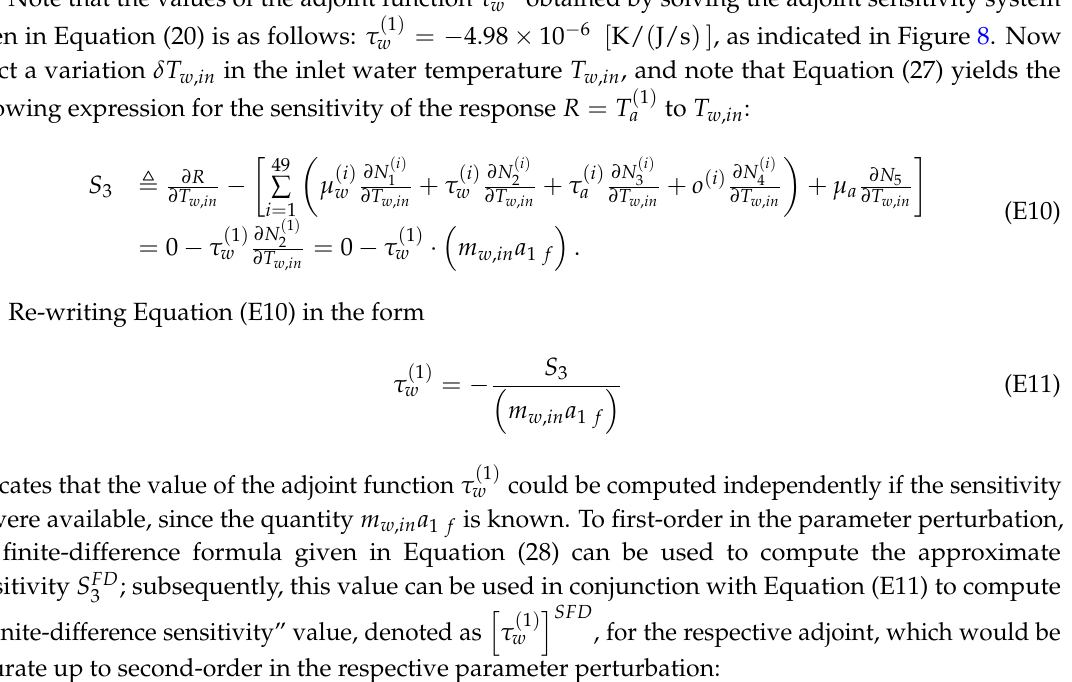
( 1 ) ( 50 ) ( 1 ) , a , T w , RH